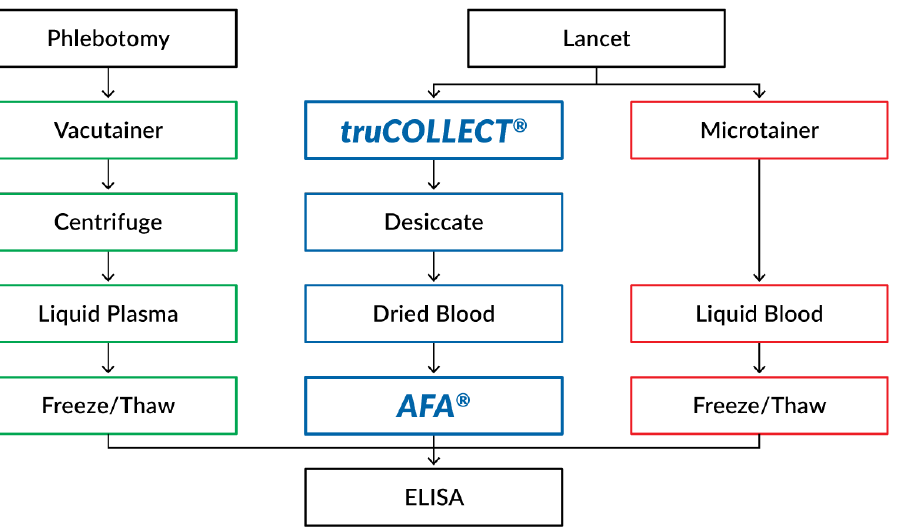
Figure 3. Experimental Workflow Diagram. A flowchart summarizing the three workflows tested for the processing of collected samples.